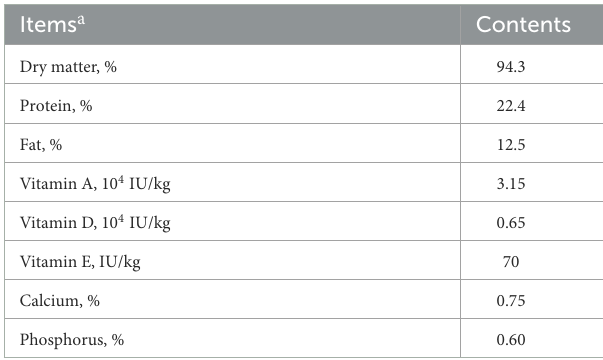
TABLE 1 The nutrient content of milk replacer.